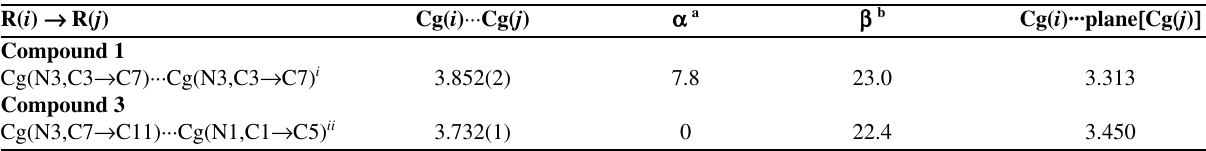
Table 4. π – π interactions (Å and